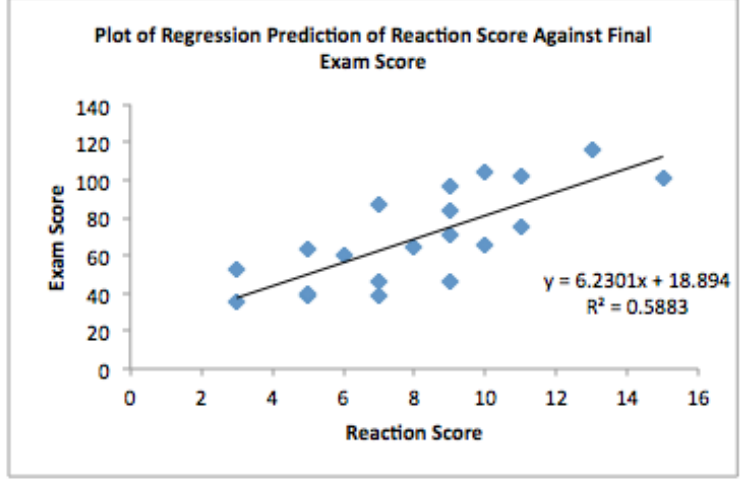
Figure 7. Regression Analysis for group B Reacton Score vs. Exam